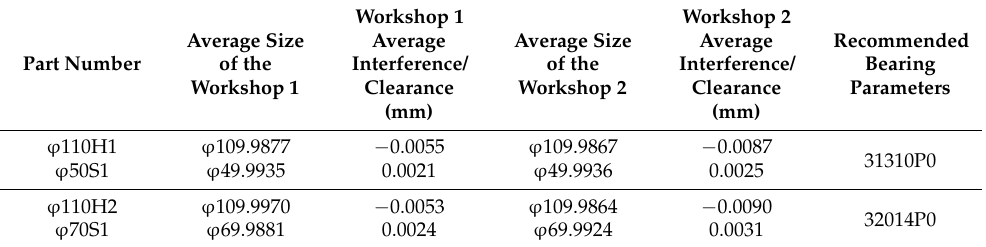
Table 12. Product scheme data.